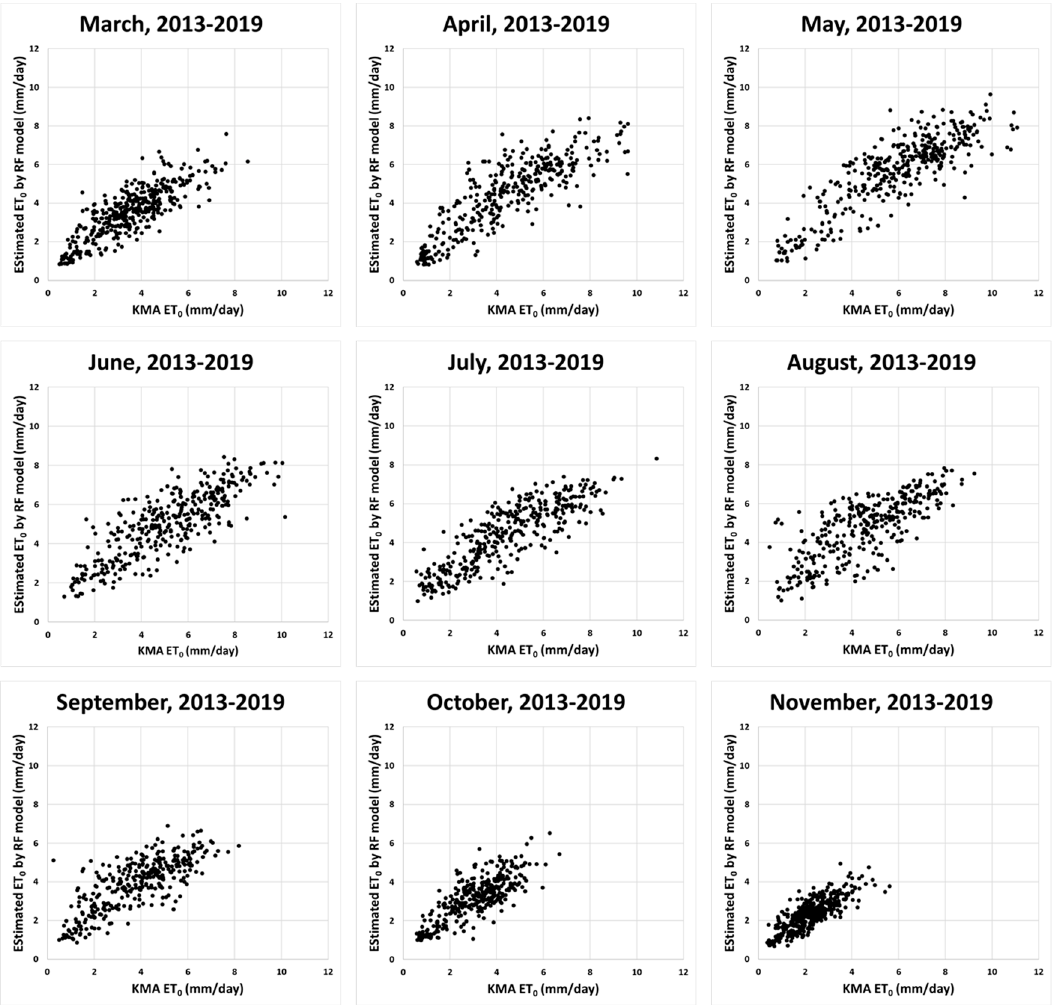
Figure 10. Scatterplots for the observed vs. estimated daily ET 0 in the blind test of the ML model in the croplands of South Korea, according to month.